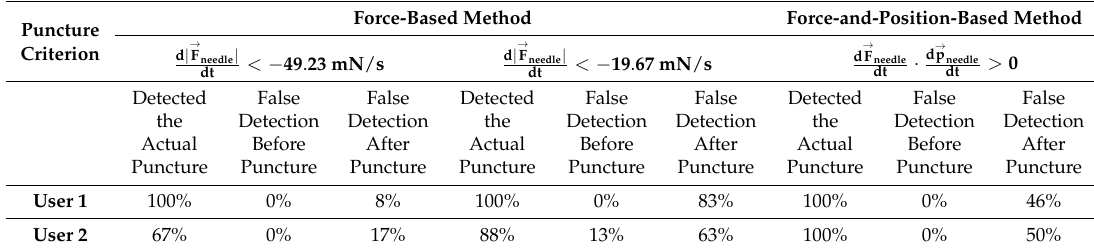
Table 2. Puncture detection rates with the force-based versus the force-and-position-based methods for two users with differing skill and experience (n = 24 trials per